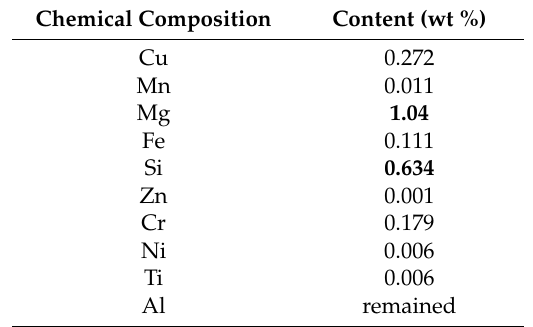
Table 1. Chemical composition of AA6061 powder (wt %).